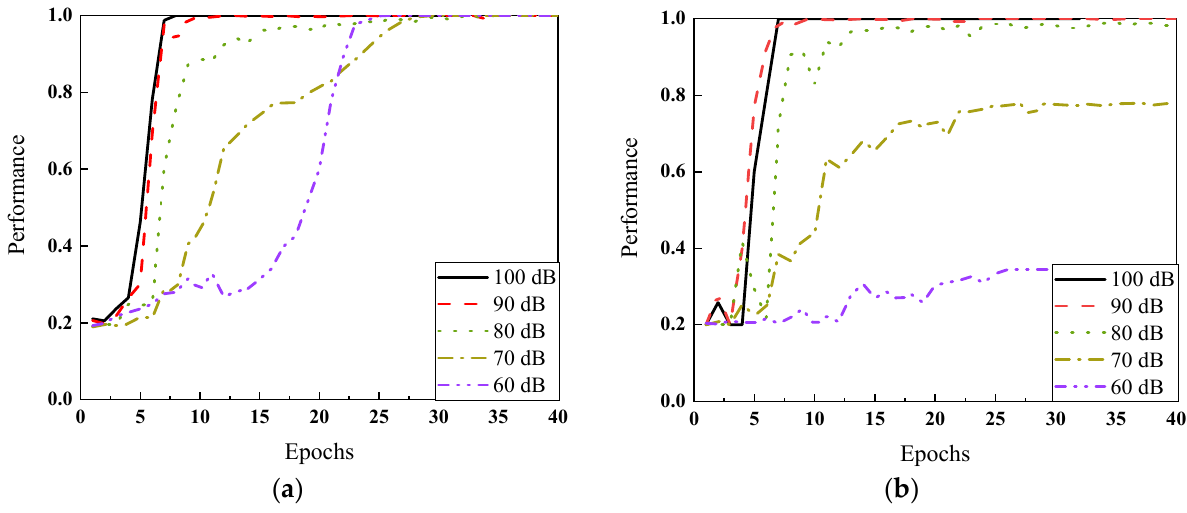
Figure 11. Learning results of CNN at various noise levels. ( a ) Training curve; ( b ) test curve.